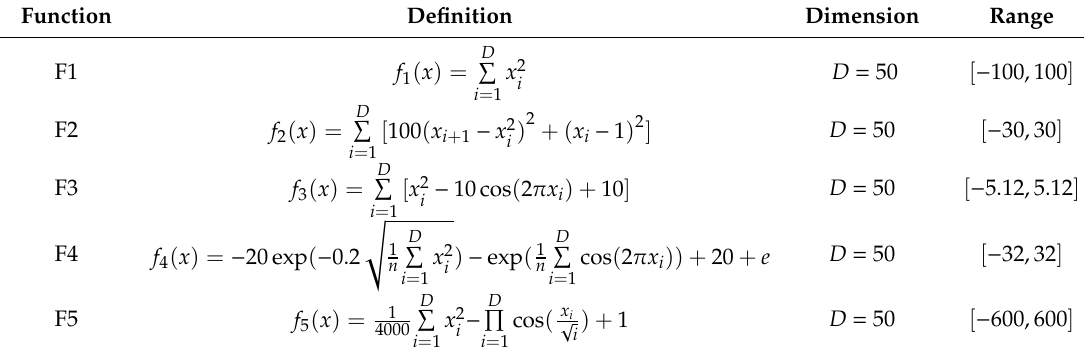
Table 1. The benchmark functions.